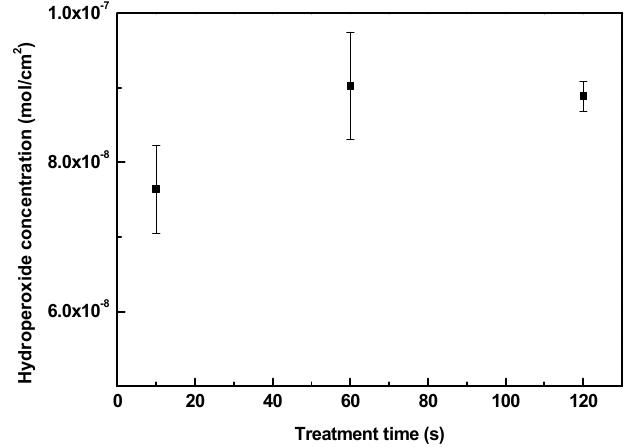
Figure 2. The peroxide concentration of plasma-treated LDPE samples.